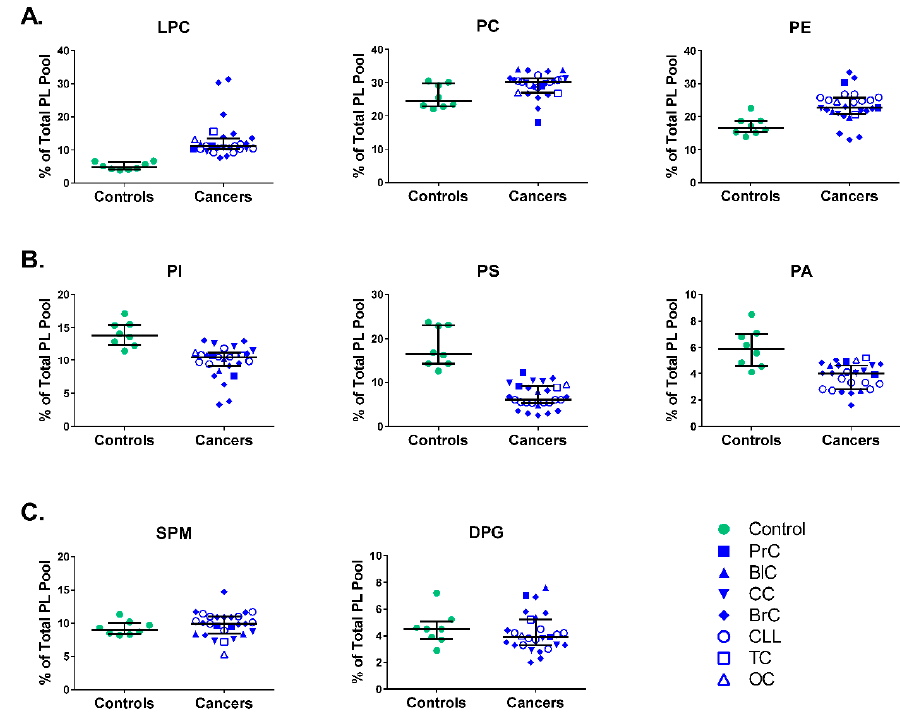
Figure 2. Different PL fractions in membranes of MNCs from healthy individuals (controls) and cancer patients (cancers) presented as % of the total PL pool calculated from the PL pool of each healthy individual or cancer patient. ( A ) LPC, PC, and PE fractions demonstrating higher levels in cancers; ( B ) PI, PS, and PA fractions with lower levels in cancers; ( C ) SPM and DPG did not show any significant differences between controls and cancers. Analysis demonstrated less spread for several PL fractions, i.e., LPL, PC, PE, PI, SPM. Data from diverse forms of cancers were pooled together, see Figure 1. Statistical differences were assessed using Mann–Whitney test and significance assessed with 95% CI.